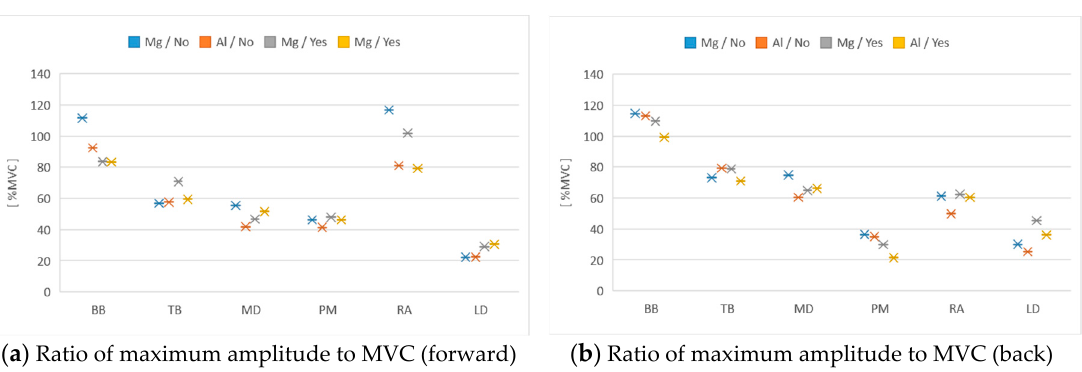
Figure 5. Ratio of maximum amplitude to maximum voluntary contraction (MVC). From the left of each figure, BB, TB, MD, PM, RA, LD and, from the left of each muscle, Mg alloy no racket, Al alloy no racket, Mg alloy racket, Al alloy racket: ( a ) forward stroke; ( b ) back